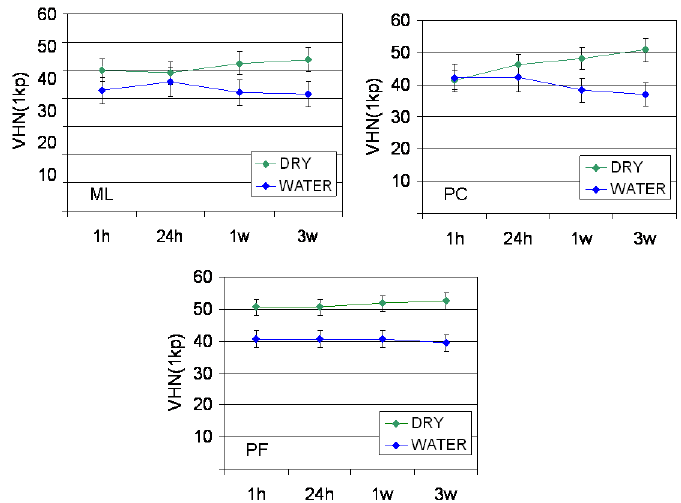
Figure 1. The results of VHN 1kp measurements. ML: Multilink Automix, PC: PermaCem 2, PF: Panavia F 2.0.